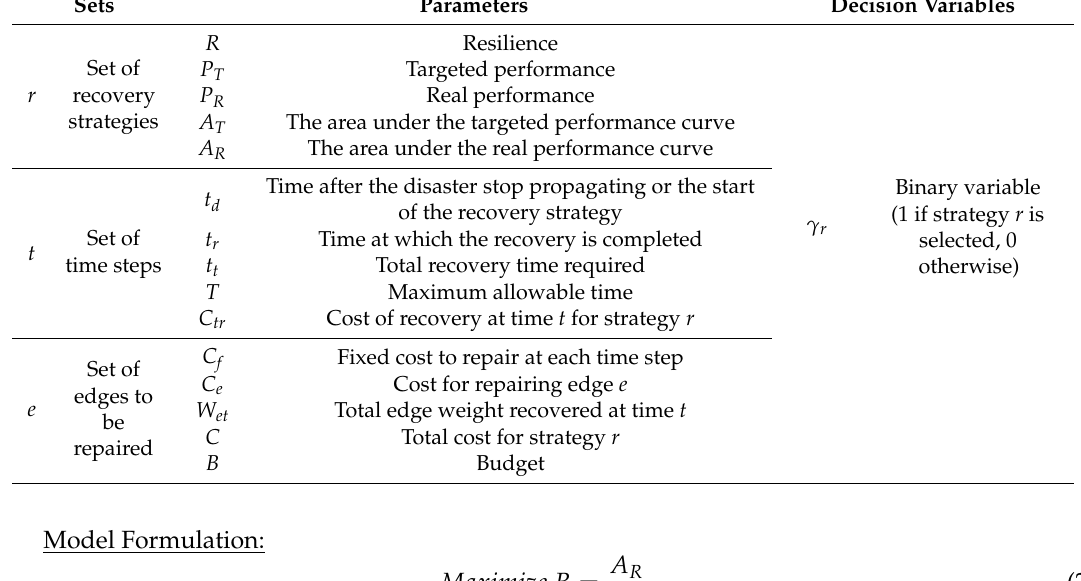
Table 1. Symbols and descriptions of parameters and